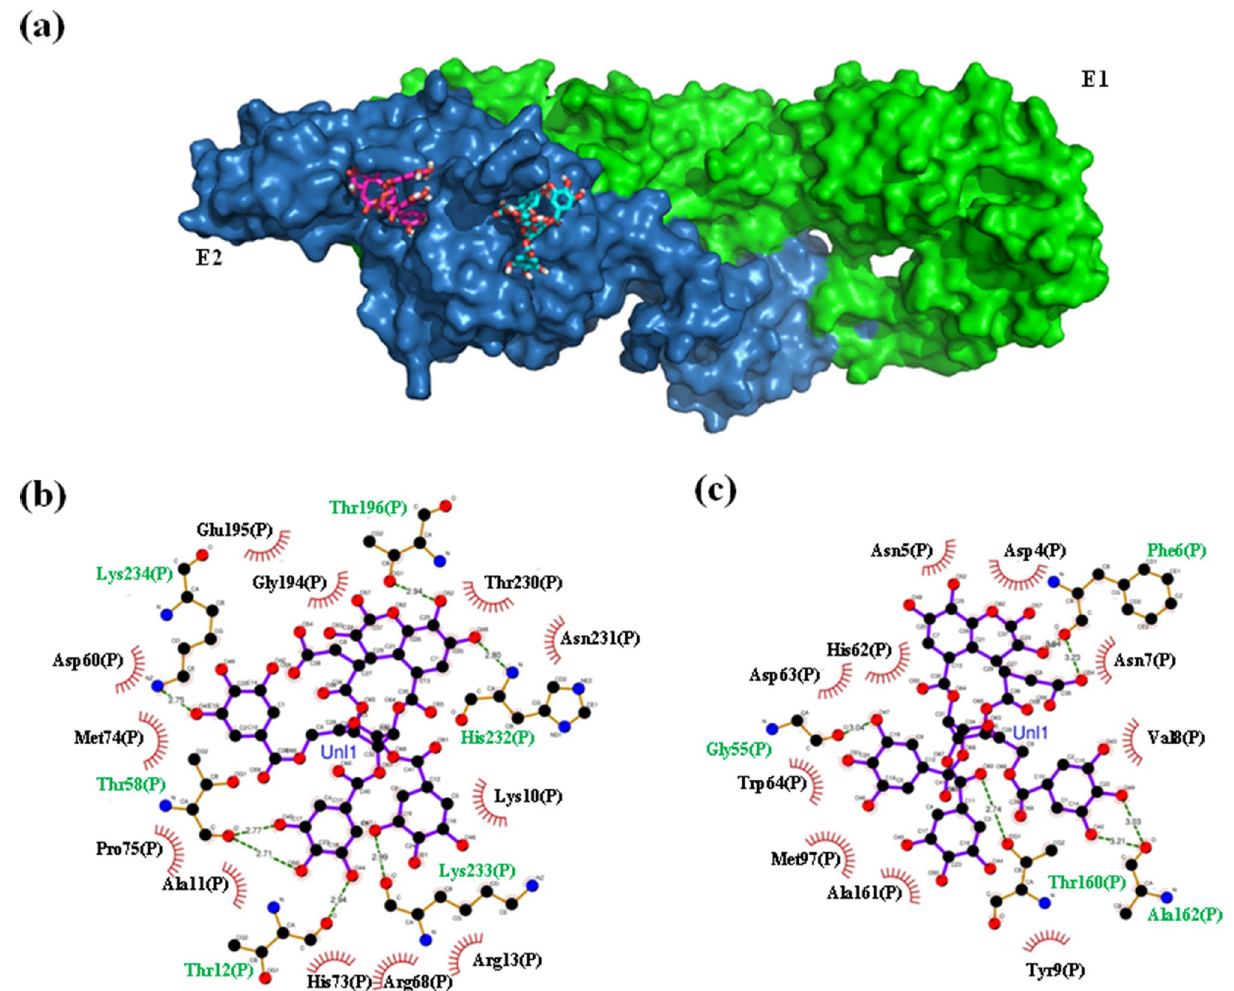
Figure 6. Structural depiction of CHIKV envelope glycoprotein E1-E2 heterodimer and chebulinic acid in their docked conformations. ( a ) Surface diagram of CHIKV E1-E2 heterodimer with docked conformations of CA molecules. The two chains of the heterodimer, E1 and E2, are represented in green and blue colors, respectively. The CA molecules bound at the pockets located at domain A and B interface of E2, and N-terminus of E2 within domain A, are depicted in sticks with carbon color scheme of pink and cyan, respectively. The oxygen and hydrogen atoms of the CA molecules are represented in red and white colors, respectively. This diagram has been prepared using the molecular visualization system PyMOL 47 . Schematic depiction of CHIKV E2-CA interactions at ( b ) pocket located at domain A and B interface of E2 ( c ) pocket located at the N-terminus of E2 within domain A, those are mediated by hydrogen bonds (dashed green lines) and by hydrophobic contacts (red arcs with spokes). These diagrams are generated by software LigPlot 45,46